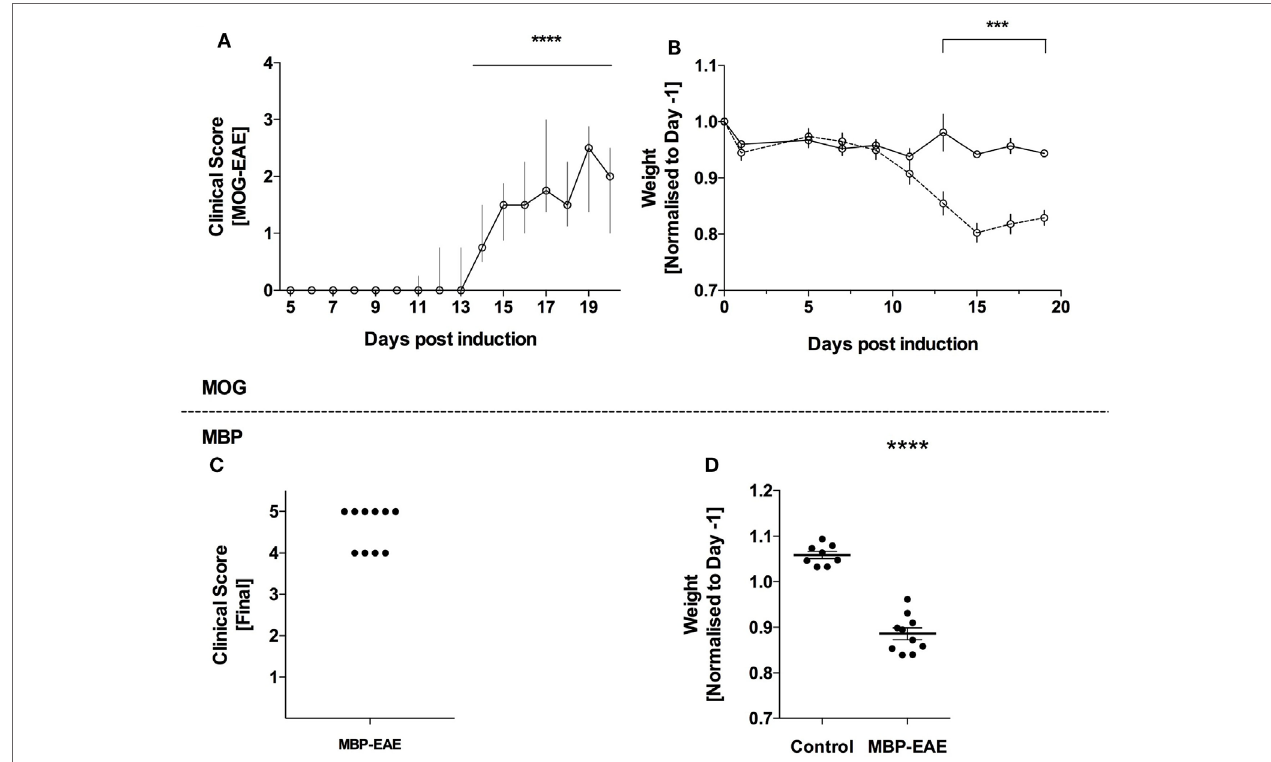
FigUre 1 | Full penetrance of experimental autoimmune encephalitis (EAE) induction in two models of multiple sclerosis. EAE was induced in C57Bl/6 mice with myelin oligodendrocyte glycoprotein (MOG-EAE) and in Lewis rats with myelin basic protein (MBP-EAE). (a) Clinical symptoms of increasing caudal–rostral CNS paralysis were significantly above zero from day 14 until peak disease. The experiment was terminated (day 20), coinciding with concomitant weight loss (B) in all mice that received MOG-EAE emulsion. MBP-EAE also induced clinical symptoms (c) and weight loss (D) in all rats receiving MBP-EAE emulsion. Data are presented as: (a) median with interquartile range; (B) average weight normalized to weight-before-emulsion (day − 1); (c) dot blot of MBP-EAE rats included; (D) dot plot of weight normalized to weight-before-emulsion (day − 1). Statistical differences were reported as *** or **** representing a p -value < 0.001 and 0.0001, respectively, after testing for normality (Shaprio–Wilk) and equal variance and running the following statistical analysis: (a) Wilcoxon signed-rank test against the hypothetical value of 0; (B) two-way ANOVA; and (D) Student’s t -test. (a,B) N = control (6), MOG-EAE (9); (c,D) N = control (8) and MBP-EAE